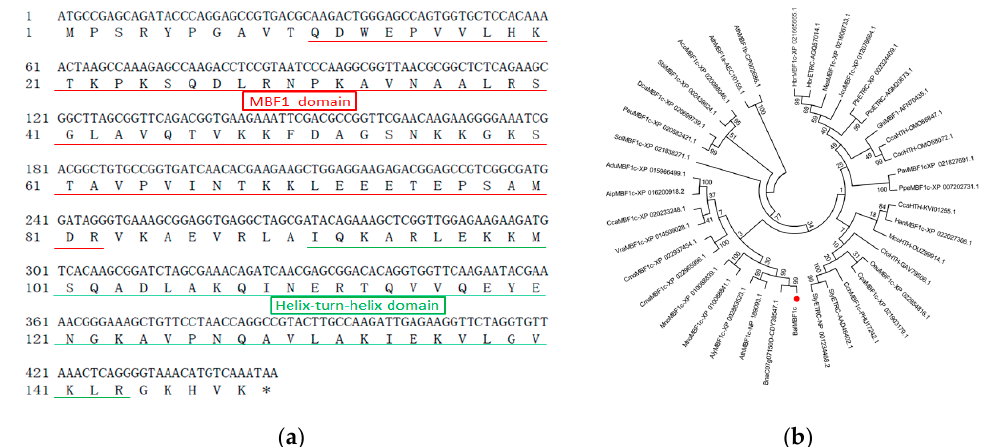
Figure 1. Sequence feature of BocMBF1c protein. ( a ) DNA and amino acid sequence of BocMBF1c. Full-length DNA and deduced amino acid sequence of BocMBF1c. Red underline indicates multi- protein bridging factor1 (MBF1) gene family domain, and green underline signatures helix-turn-helix (HTH) domain. ( b ) Phylogenetic tree constructed by the neighbor-joining method based on the MBF1c amino acid sequences.